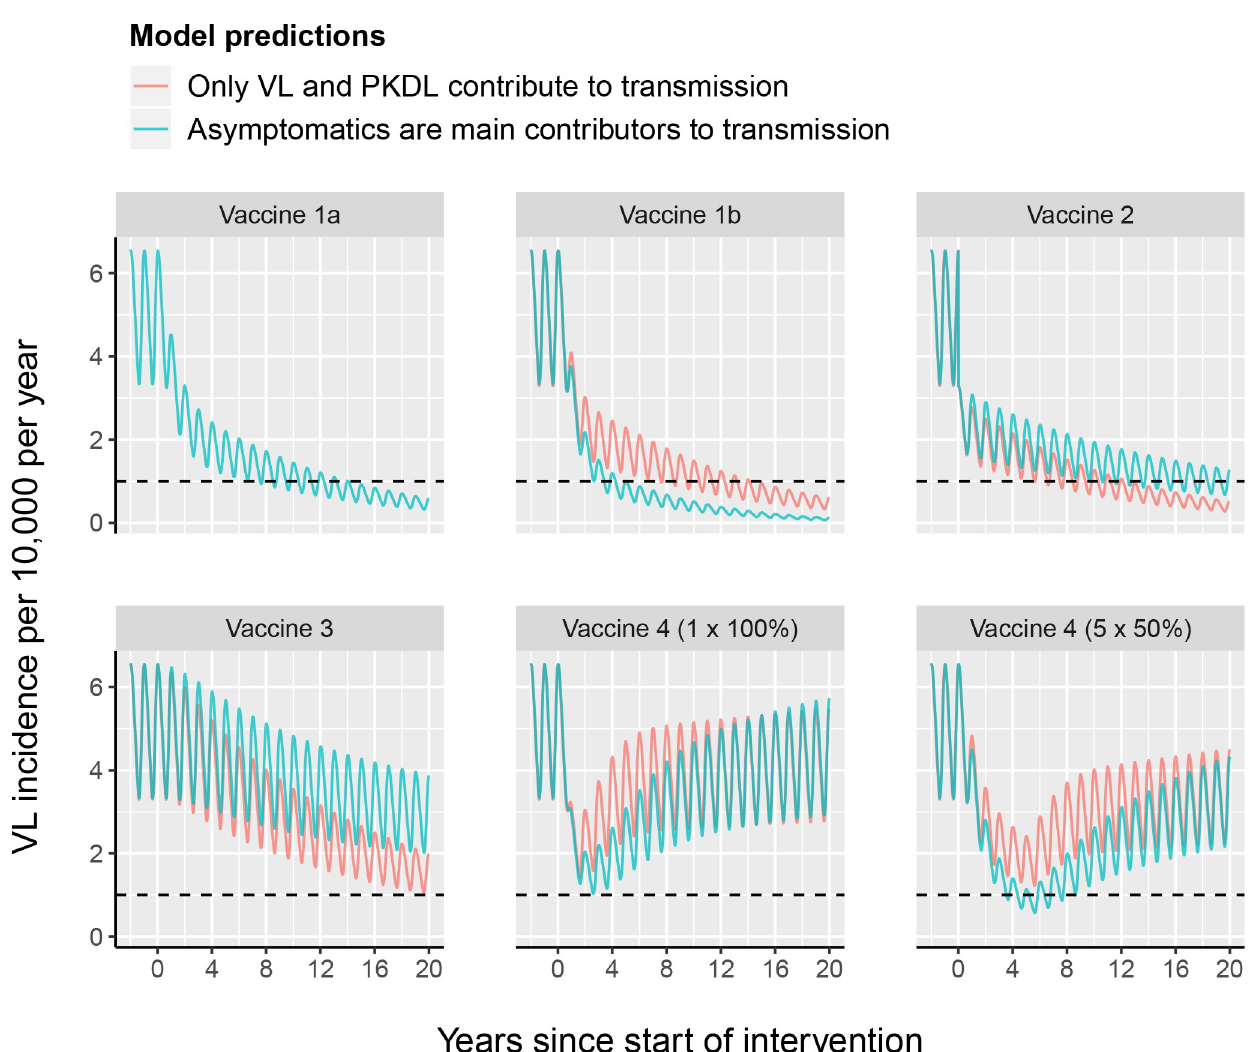
Fig 2. The impact of different vaccine characteristics on VL incidence using model variants with and without asymptomatics contributing to transmission in a setting with a pre-control endemicity of 5/10,000/year. Vaccine characteristics are in place continuously from year 0 onwards, unless for vaccine characteristic 4, which is administered once (1 x 100%), or yearly for five years in a row (5 x 50%). The different vaccine characteristics that are also explained in Table 1 and illustrated in Fig 1, are; 1a) early and late asymptomatic individuals become half as infectious, 1b) all infection states become half as infectious, 2) vaccinated individuals are 50% less likely to develop symptoms, 3) vaccinated individuals are 50% less likely to develop PKDL, and 4) vaccinated individuals become immediately immune. The black dashed line represents the WHO elimination target of 1/10,000/year. The oscillations in VL incidence are a result of seasonality in the sand fly